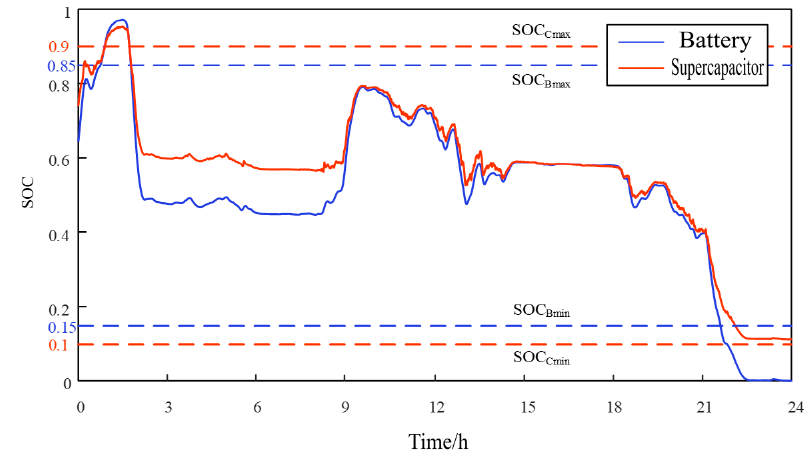
Figure 7. SOC curve of each energy storage element before control.